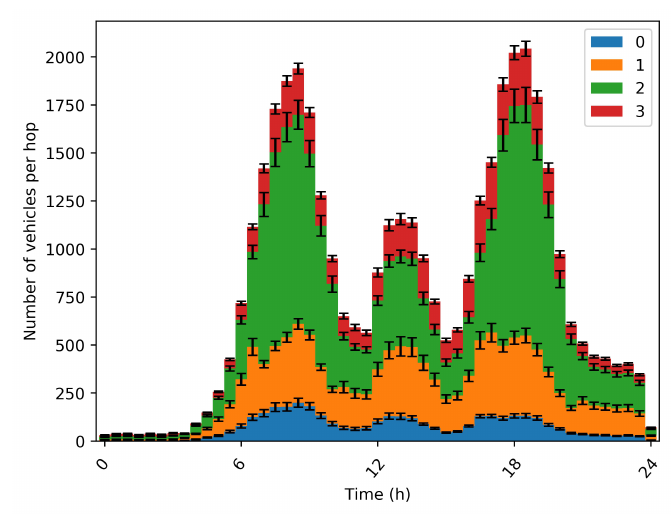
Figure 9. Number of vehicles per hop—Dynamic-1.